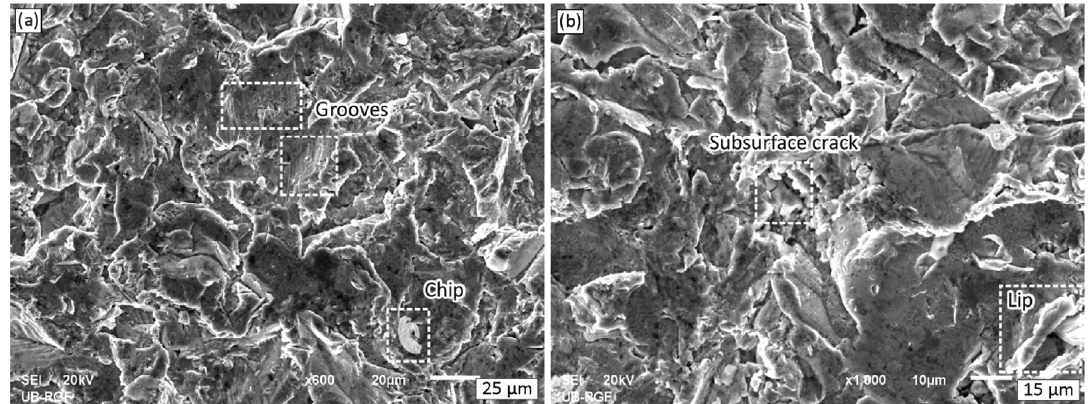
Fig. 7 Worn surface top-view of nanocomposite N3: 0.5-50, reinforced with SiC nanoparticles, at different magnifications of